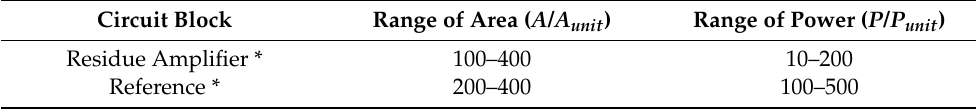
Table 2. Ranges of the area and power normalized to the unit